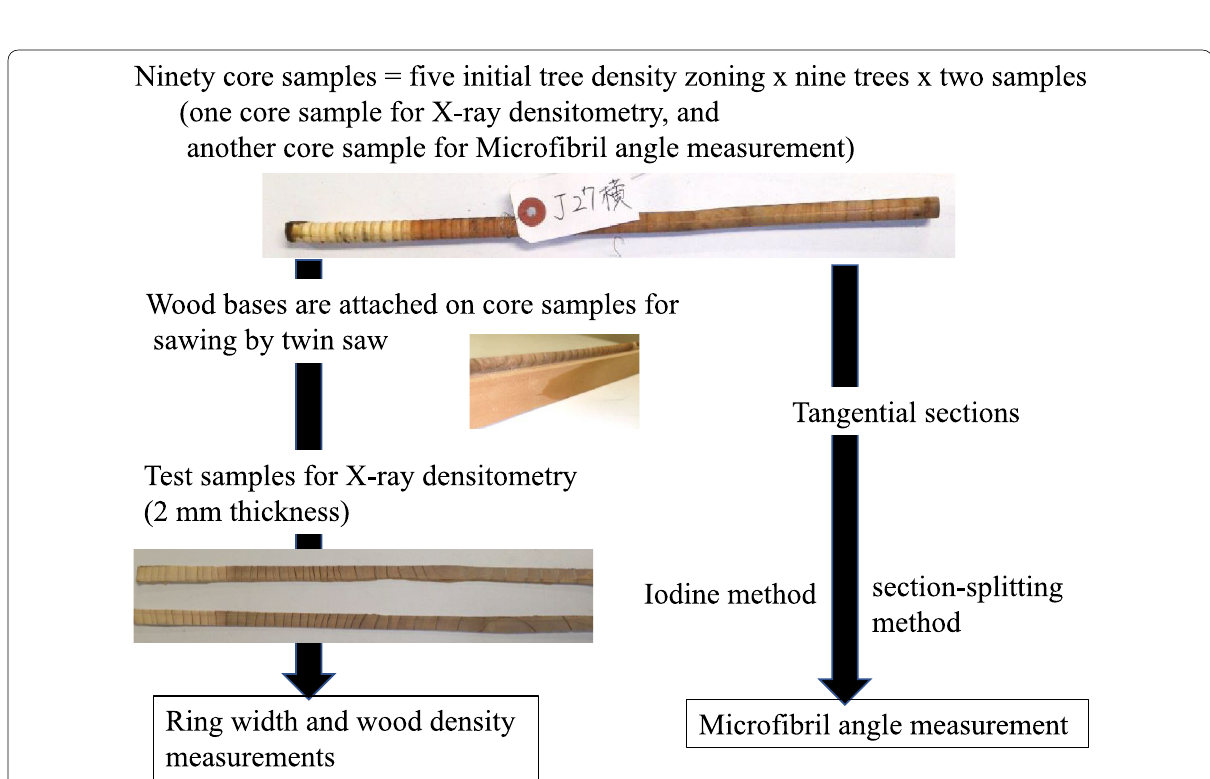
tree height (m)/diameter at breast height (cm) =